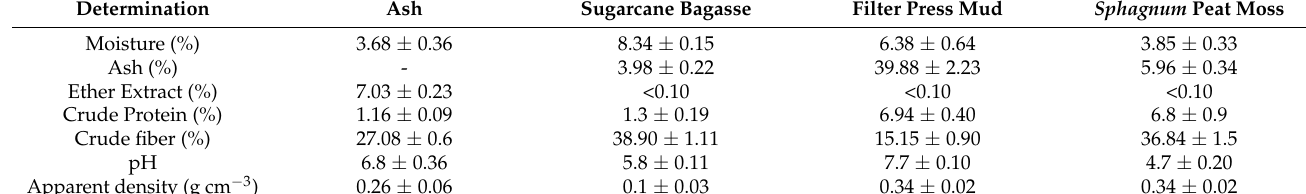
Table 1. Proximate analysis and physico-chemical properties of the raw materials used as growing substrates in this study. Determination